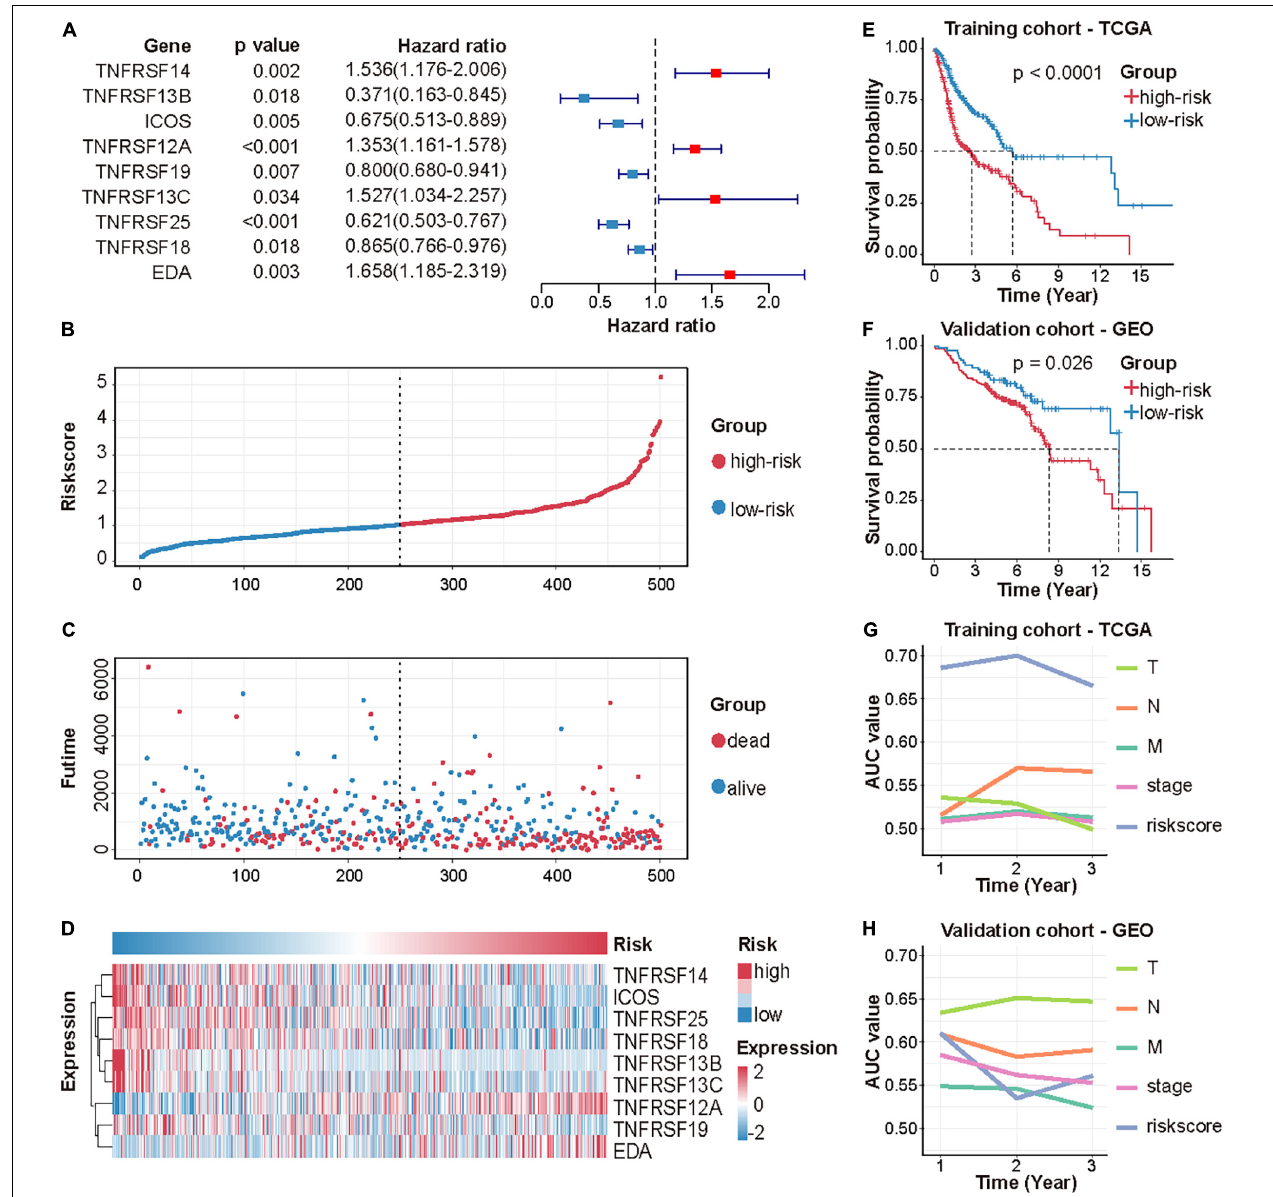
FIGURE 2 | Identification and validation of CMS in HNSCC. (A) A forest plot of multivariate Cox regression analysis of 9 CMGs in HNSCC. The risk score distribution of each patient (B) , the survival time and status of each patient (C) , and the expression of 9 CMGs in each patient (D) . (E,F) Survival analysis of CMS in the TCGA and GEO dataset by performing the log-rank test. (G,H) AUC values of CMS and other clinical indices were determined in the TCGA and GEO dataset by performing ROC curve